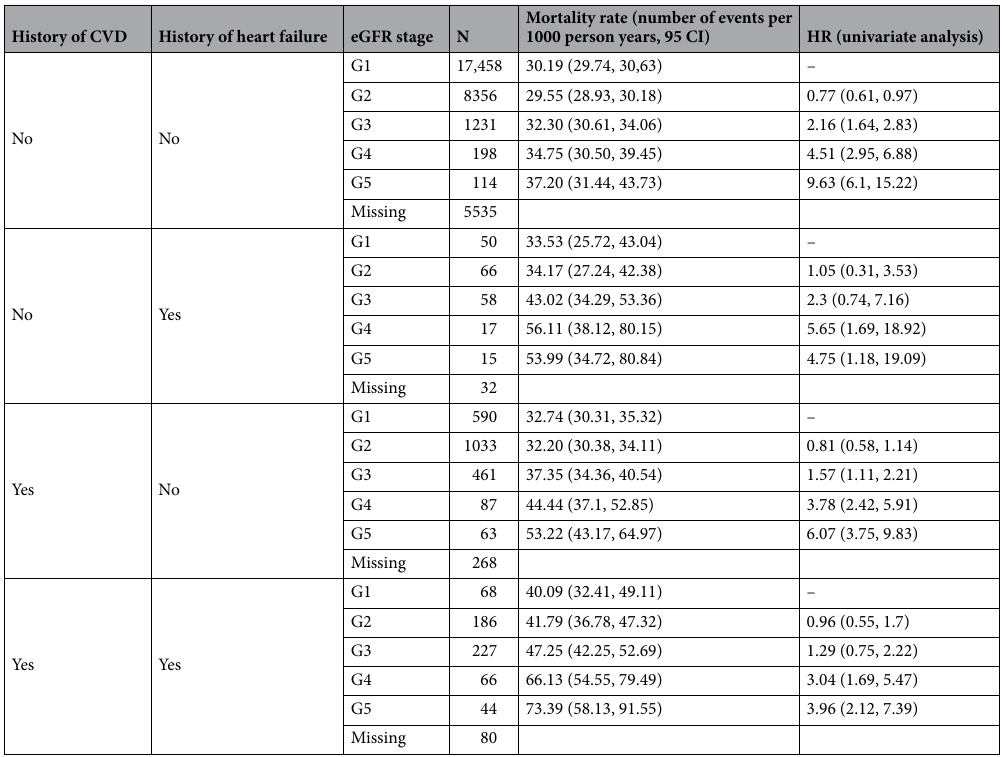
History of CVD History of heart failure eGFR stage N